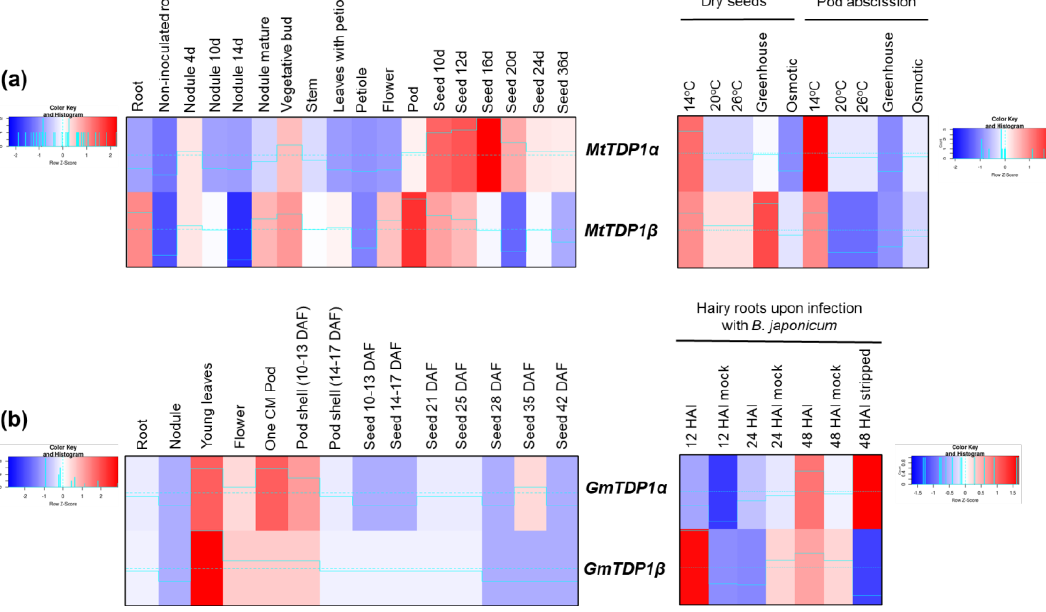
Figure 7. Expression profiles of the TDP1α and TDP1β genes in cereal crops. ( a ) M. truncatula. ( b ) G. max. Expression data from different tissues and stress conditions are given in heatmaps generated based on Z-score values at http://shinyheatmap.com/.